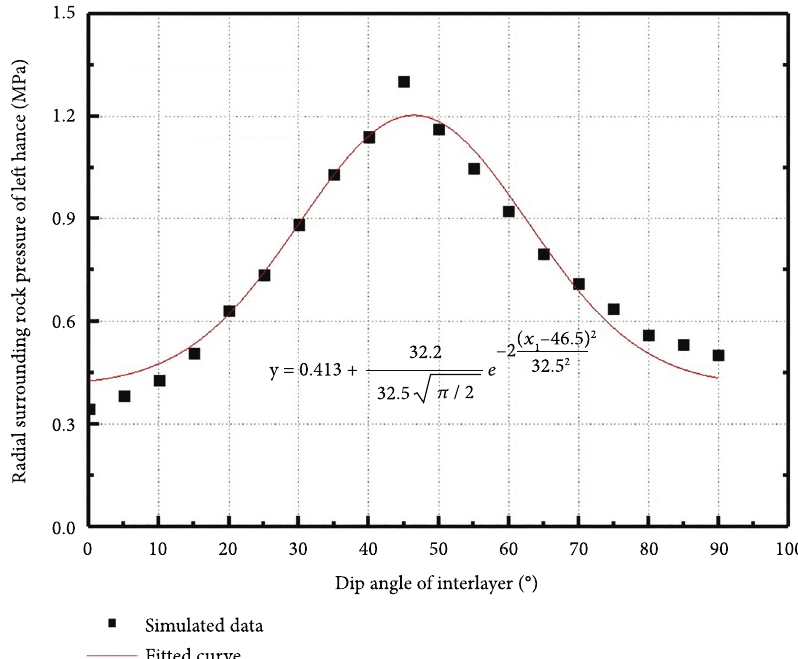
Figure 4: Fitting curve of the relationship between the surrounding rock pressure of left hance and the weak interlayer with di ff erent dip